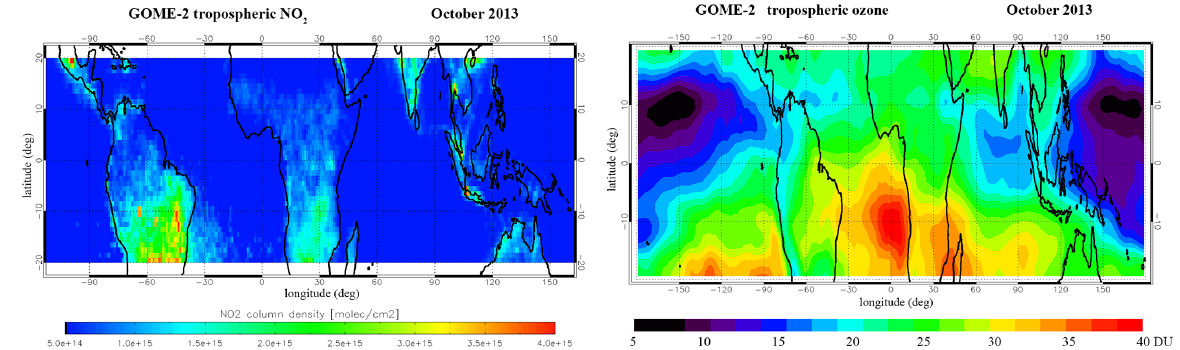
Figure 5. Tropospheric NO 2 (left) and ozone columns (right) for October 2013, as retrieved from GOME-2 data of both MetOp-A and